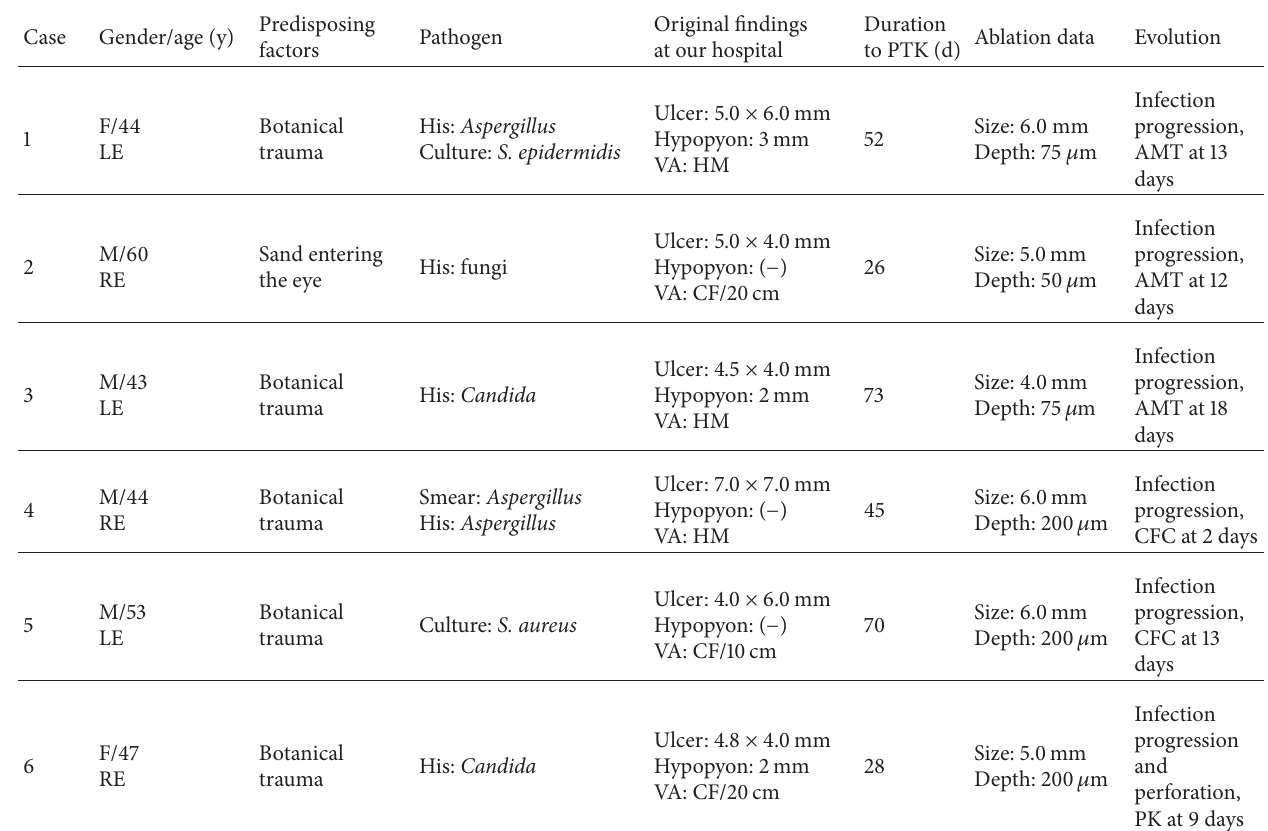
Table 3: Demographic, clinical, and surgical data on six failure cases with phototherapeutic keratectomy. Predisposing Case Gender/age (y)